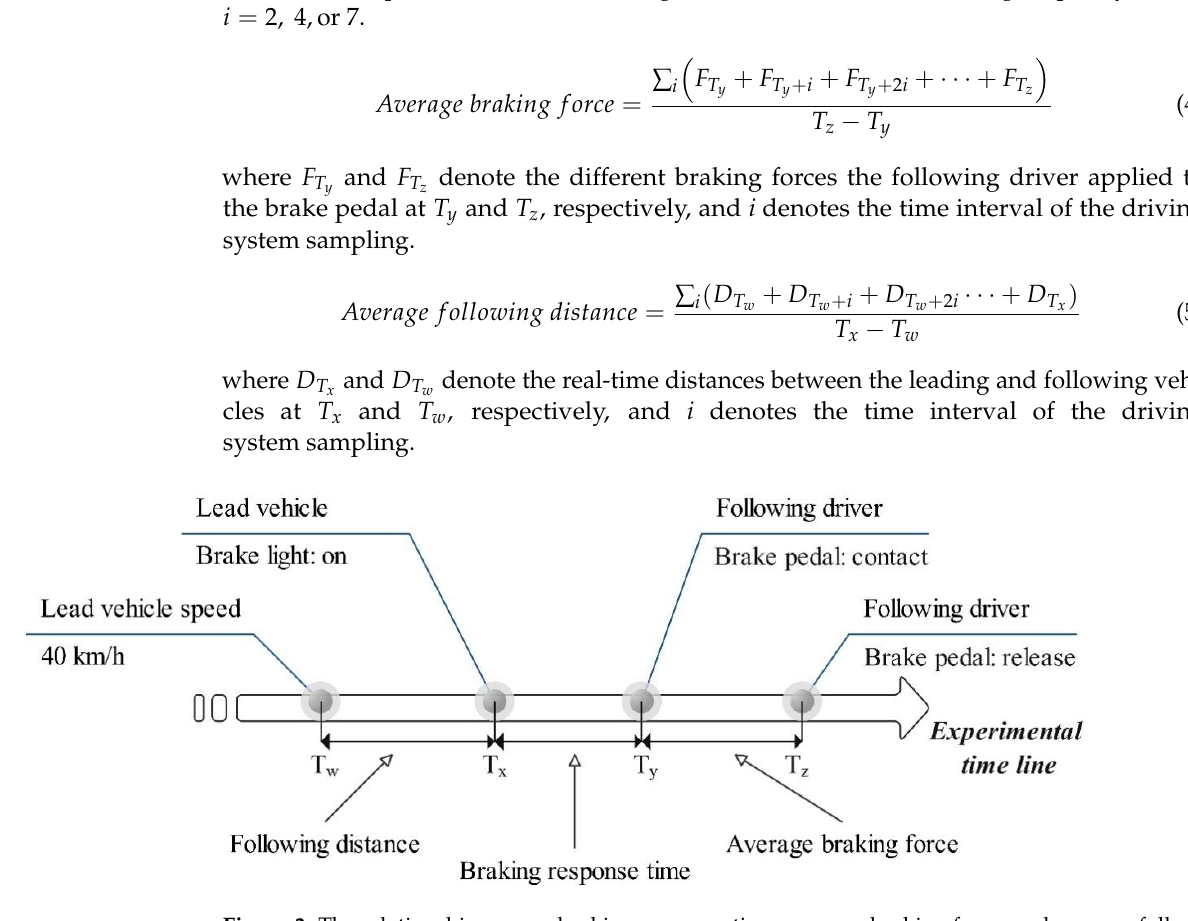
Figure 3. The relationship among braking response time, average braking force, and average following distance.